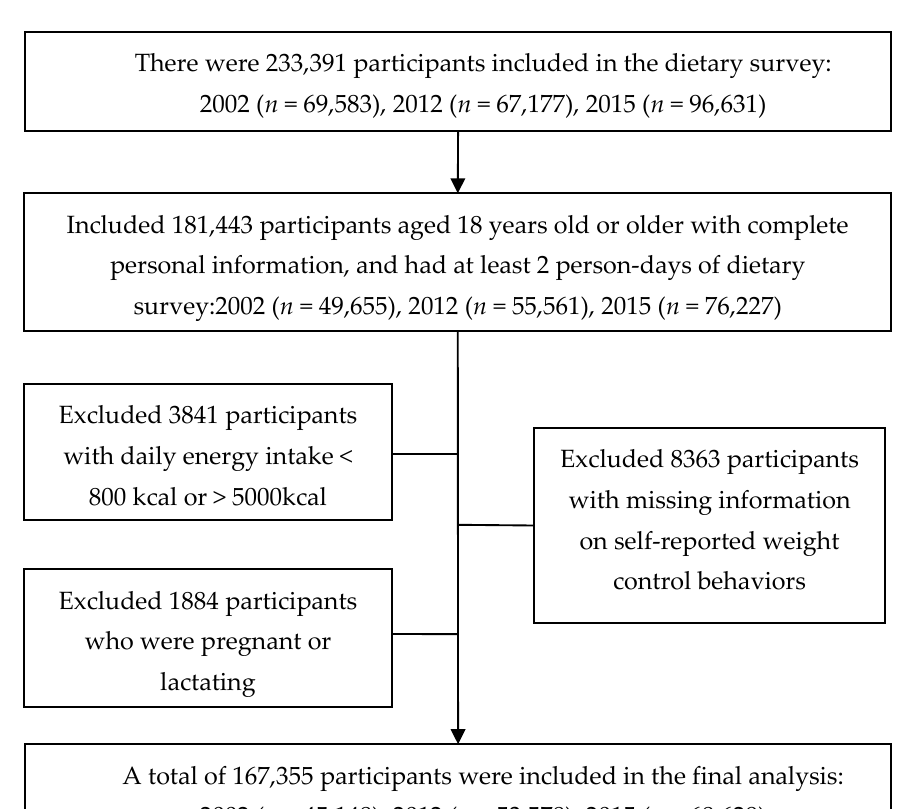
Figure 1. Flow of inclusion into the study.